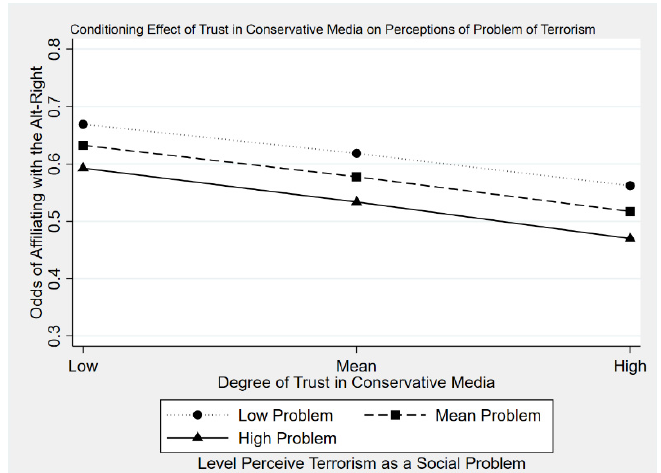
Figure 6. Conditioning Effect of Conservative Media: Terrorism and the Alt-Right.